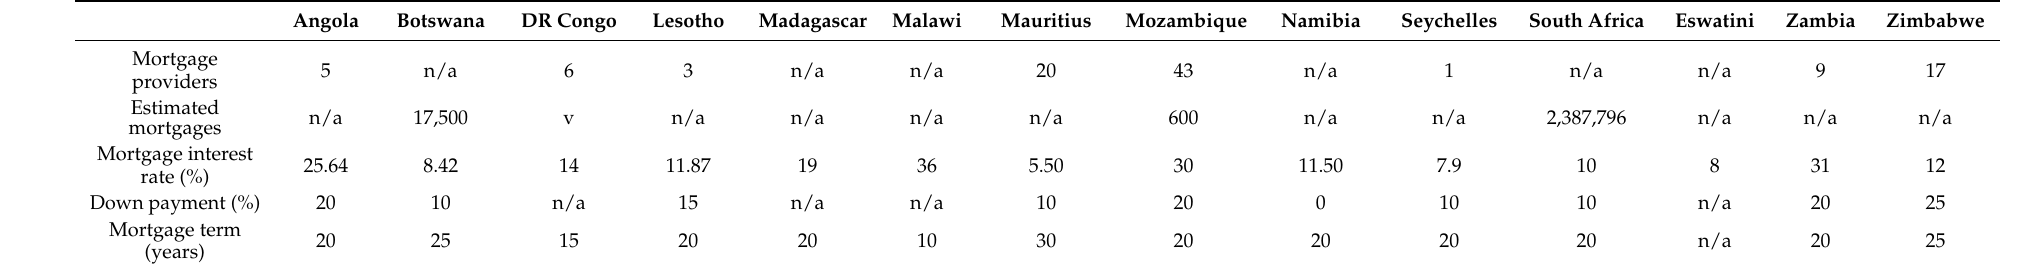
Table 2. Housing finance information in Southern Africa,